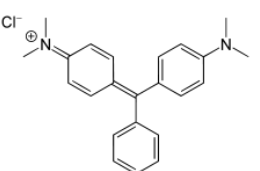
Figure 7. The structural formula of Malachite Green dye.